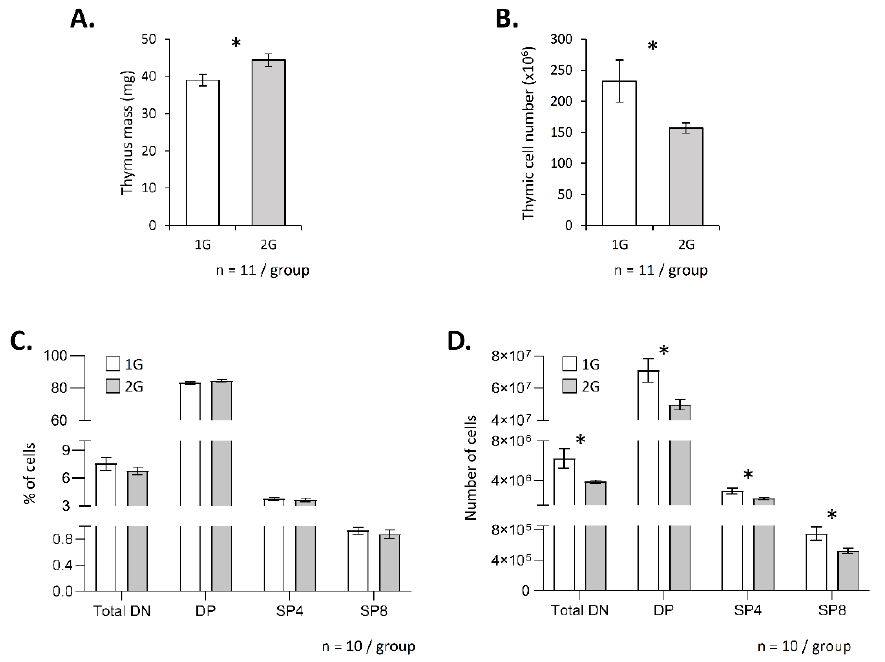
Figure 1. Hypergravity affects T lymphopoiesis. Thymus mass ( A ) and thymic cell number ( B ) in adult mice exposed to 2× g hypergravity for three weeks. ( C , D ) Analysis of T lymphopoiesis by flow cytometry. T-cell subpopulations were identified using CD4, CD8, CD3 and TCR staining. For each mouse, staining was done in duplicate, and mean was calculated. ( C ) Percentage of each subpopulation. ( D ) Absolute number of cells in each subpopulation. Data are the mean ± SEM of 11 ( A , B ) or 10 mice ( C , D ) per group. Mann–Whitney or t -tests were used to reveal statistically significant differences. * p <